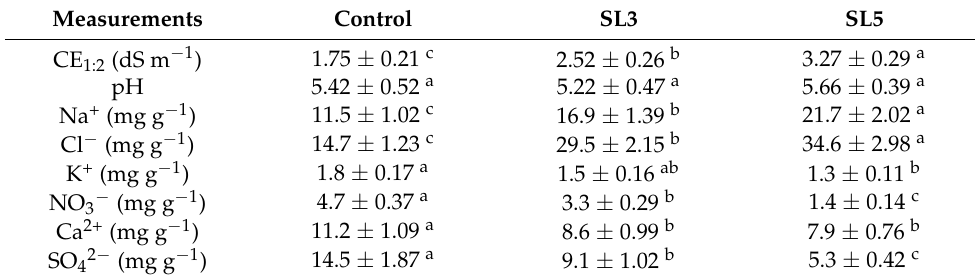
Table 5. EC 1:2 , pH, and ion content of the substrate at the end of the experiment, for